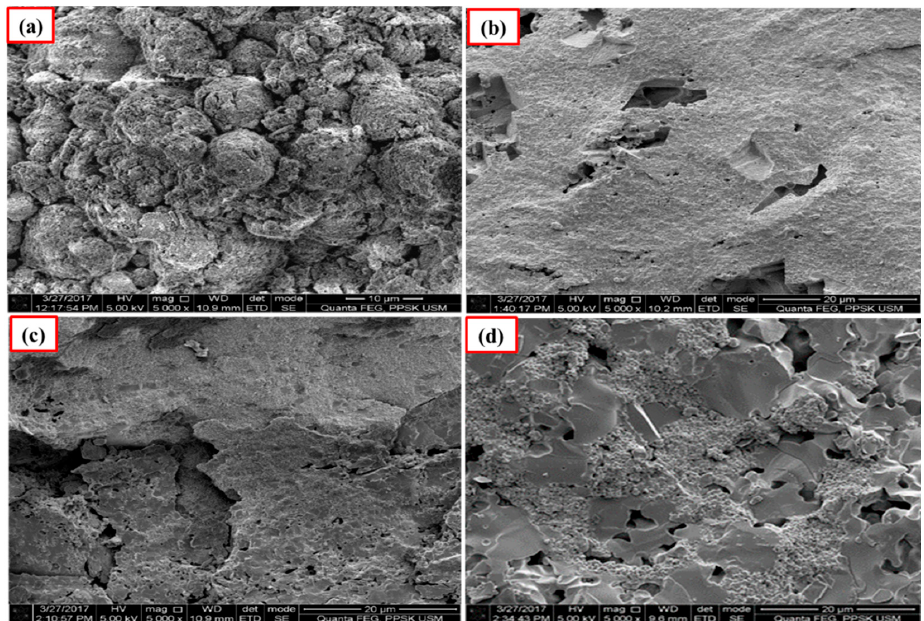
Figure 5. SEM images of the unpolished Ca-SZ(CC) sintered for 2 h at ( a ) 1200 °C; ( b ) 1300 °C; ( c ) 1400 °C and ( d ) 1500 °C.